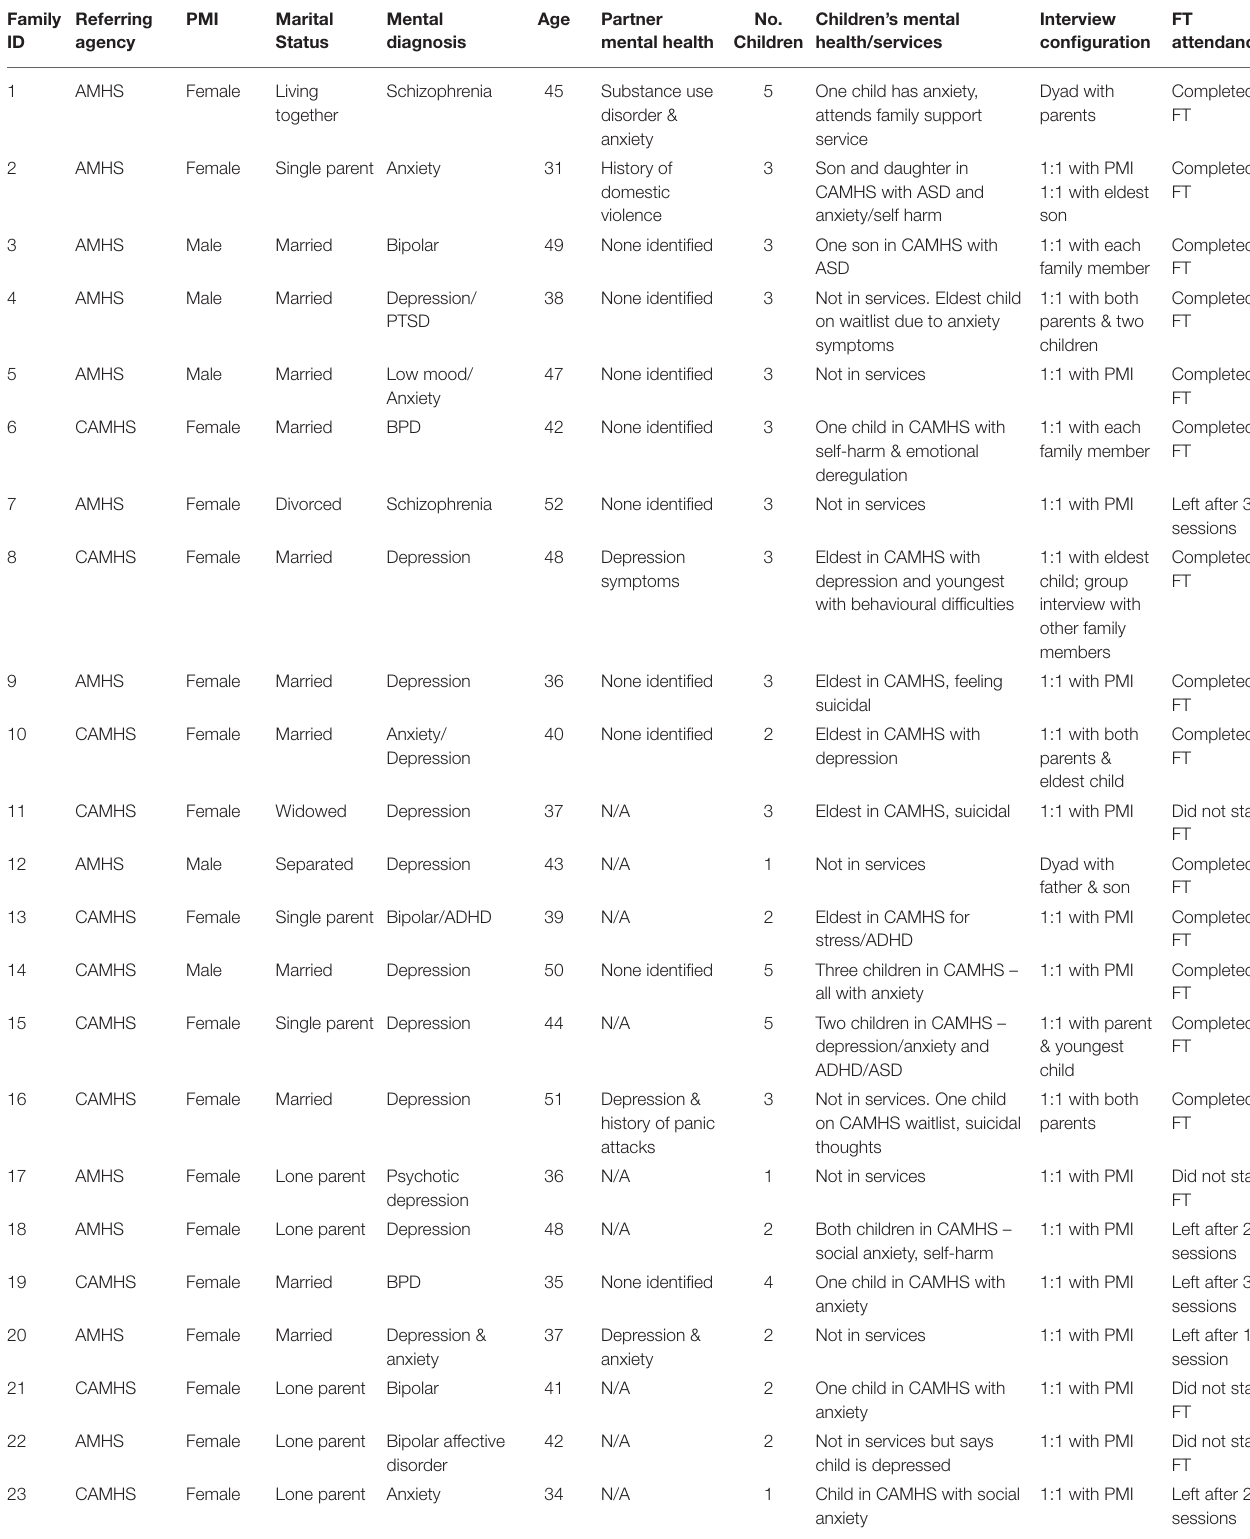
TABLE 2 | Characteristics of interviewed families. Family